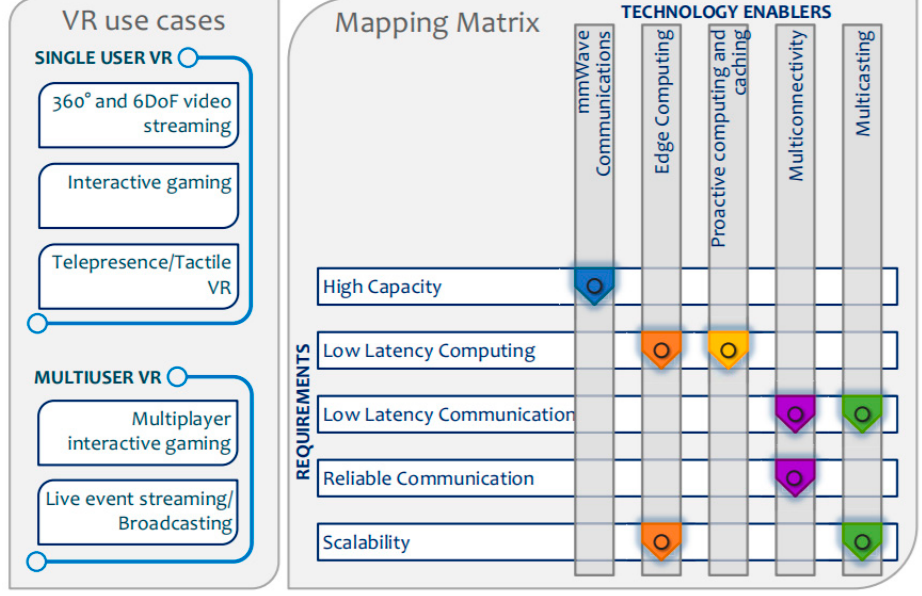
Figure 13. Single and multiple user VR use cases: requirements and enablers [56].